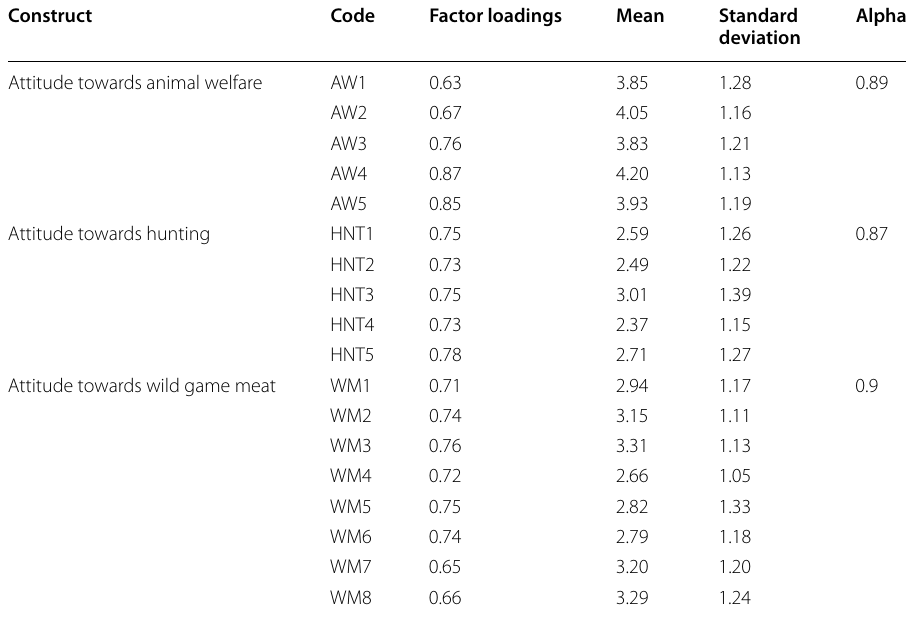
Table 5 Factor loadings, median, and standard deviation of the various constructs and Cronbach’s alpha of scales